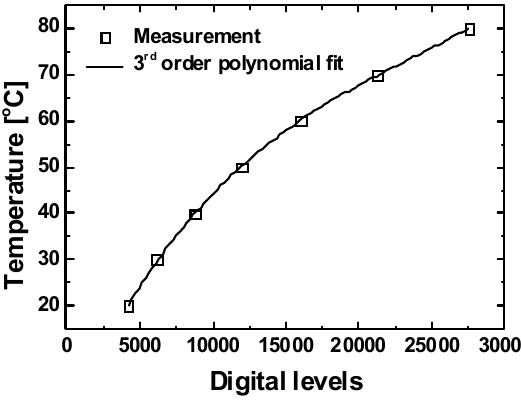
Figure 3. Nonlinear calibration curve for the blackbody temperature and response output values of the infrared camera (digital levels).